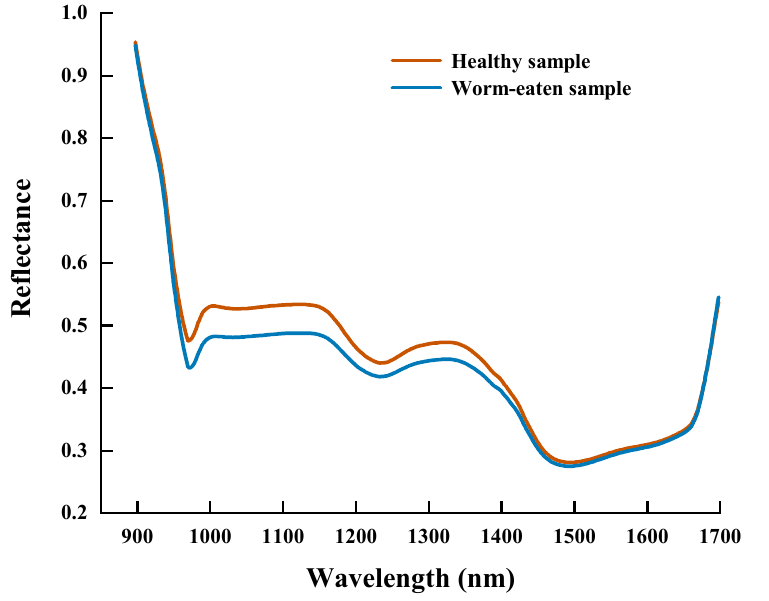
Figure 7. The average spectral curve of maize seeds.